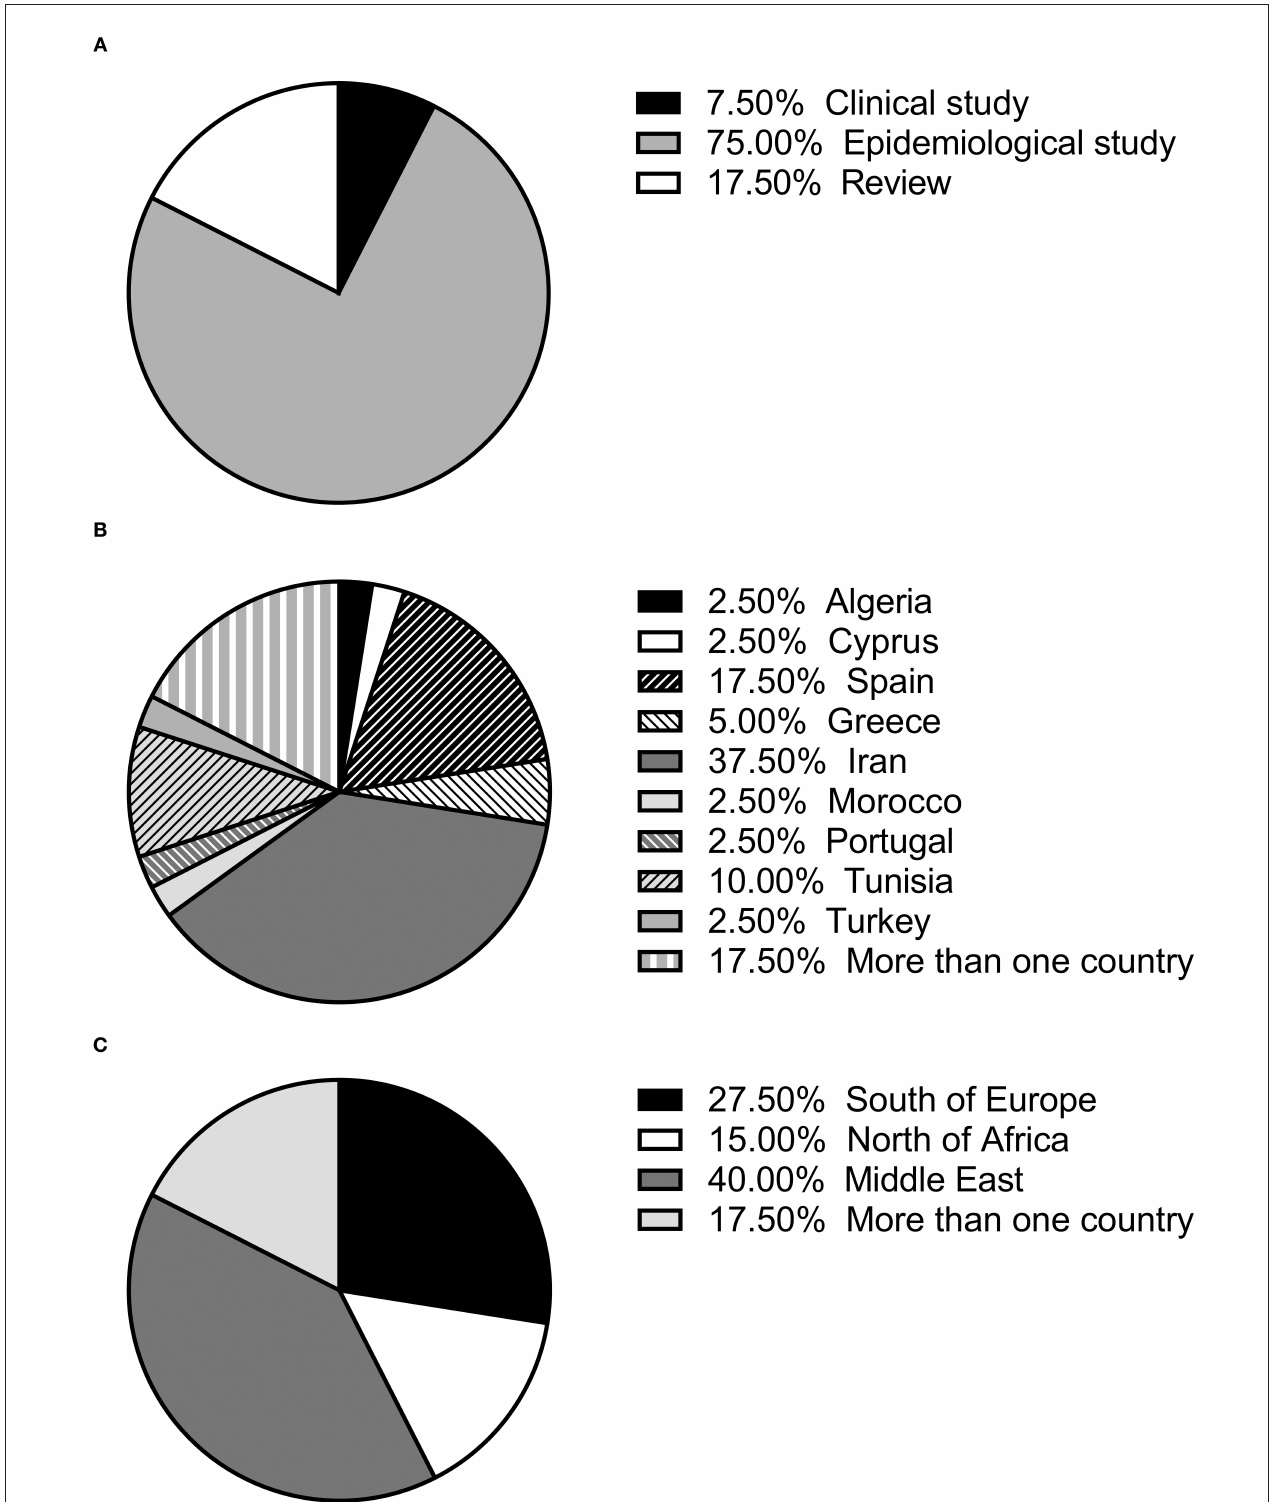
FIGURE 1 | (A) Percentage of each type of study (review, clinical or epidemiological); (B) percentage of studies published in each country; (C) percentage of studies published in each geographical area.